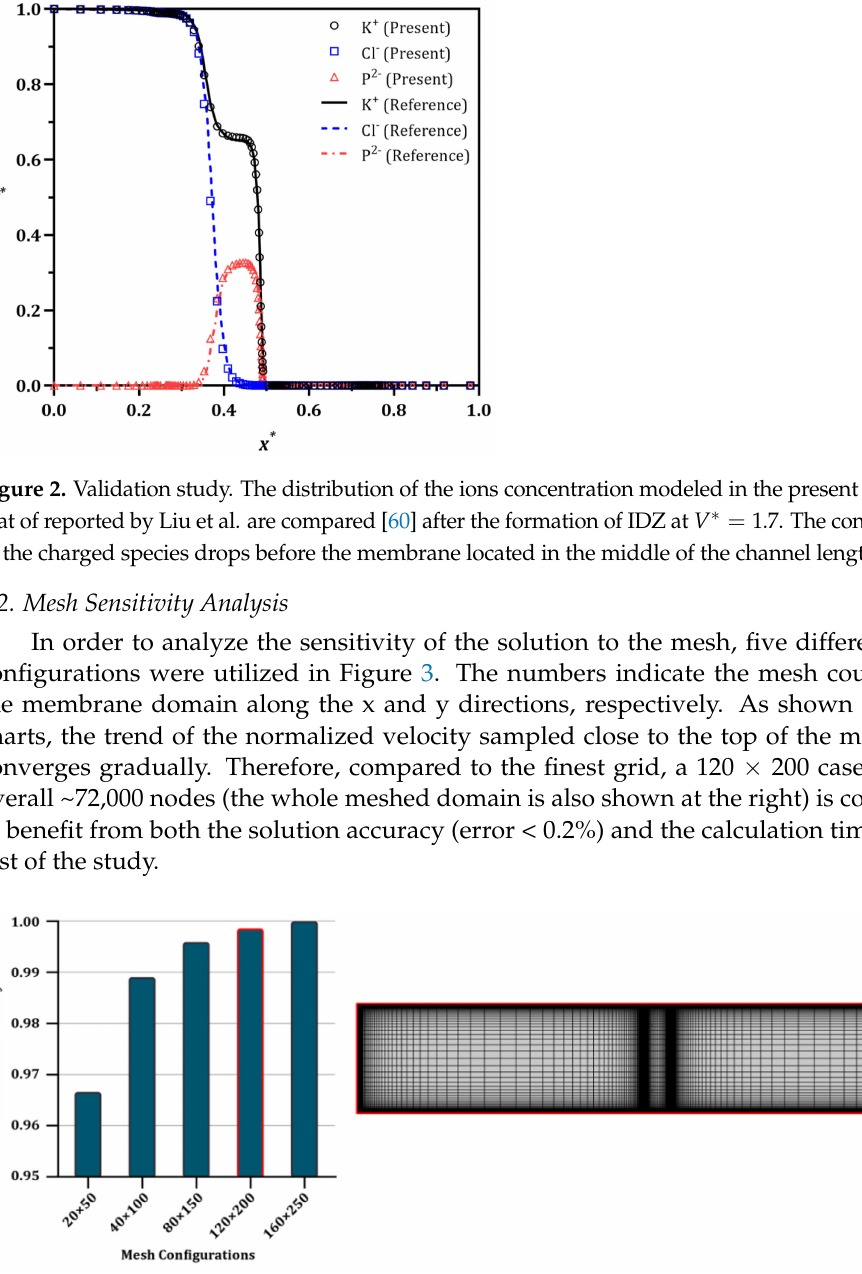
Figure 3. Mesh sensitivity analysis and the whole meshed domain using the final grid configuration (120 × 200), with highest mesh density in the vicinity of channel walls and in the ICP vortex domain. The red border of the fourth column indicates the selected mesh